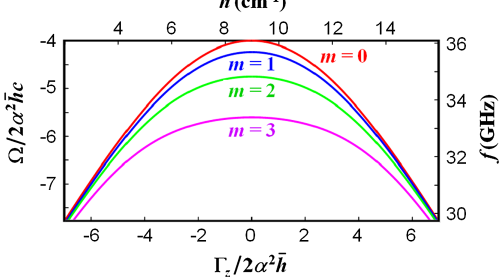
FIG. 2. Dispersion lines of the normal waves with various azimuthal indices m slowed by the 2D corrugation, which were obtained by solving Eq. (12) for the geometrical parameters given in Table I, f ¼ ω = 2 π